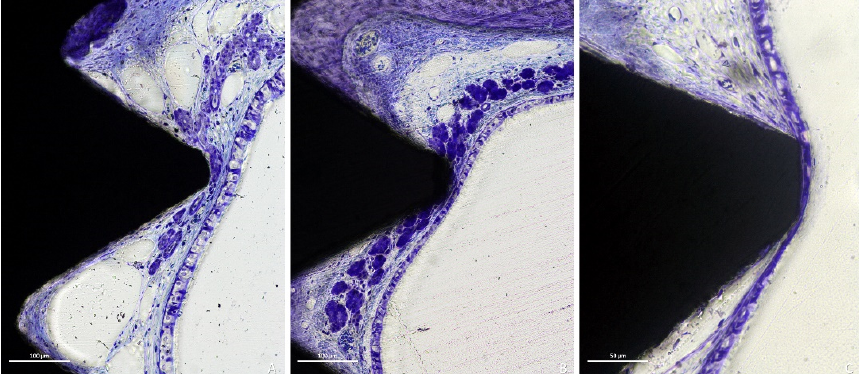
Figure 7. Photomicrographs of ground sections. ( A ), initial stage of thinning mucosa, vessels and mucous glands were dislocated and deformed by the thread tips without damages of the pseudostratified ciliated columnar epithelium. ( B ), more advanced thinning presenting a complete dislocation and deformation of the submucosa, vessels and mucous glands. ( C ), severe stage presenting a progressive thinning of the epithelium layer and a loss of goblet cells and cilia. ( A – C ), Toluidine blue stain.